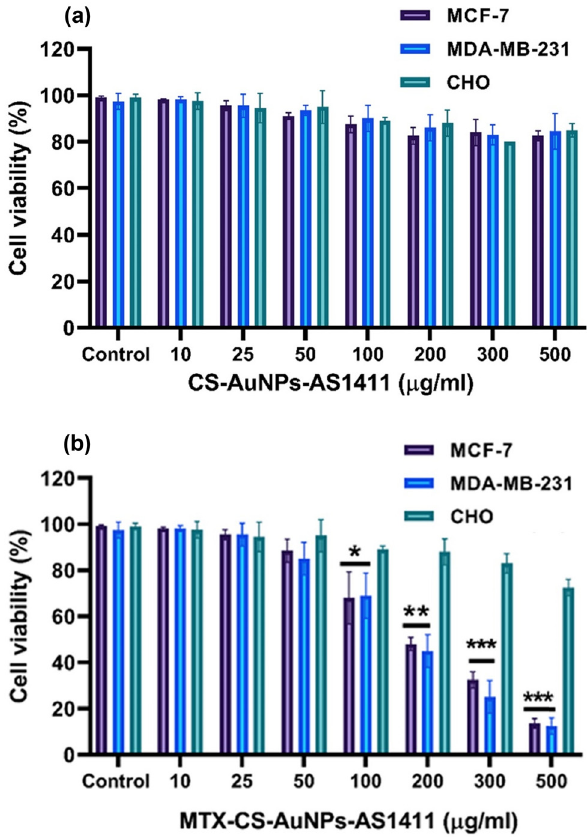
Figure 4: ( a ) E ff ect of Apt - AuNPs - CS ( without MTX ) and ( b ) MTX - Apt - AuNPs - CS on CHO ( non - target ) , MDA - MB - 231 ( target ) , and MCF - 7 ( target ) cell viabilities. The values are stated as mean value ± SD. * p < 0.05 shows signi fi cant di ff